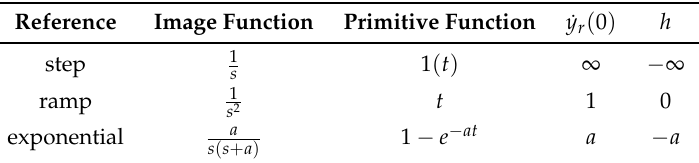
Table 1. Three classic linear references.